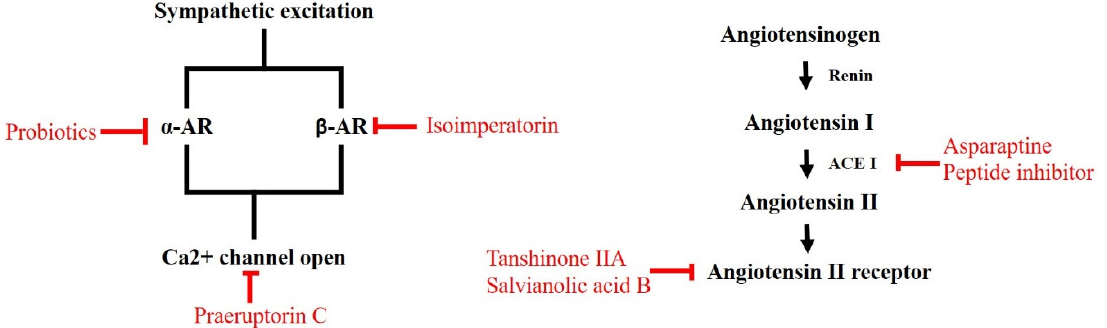
Figure 2. Natural compounds act on blood pressure control.